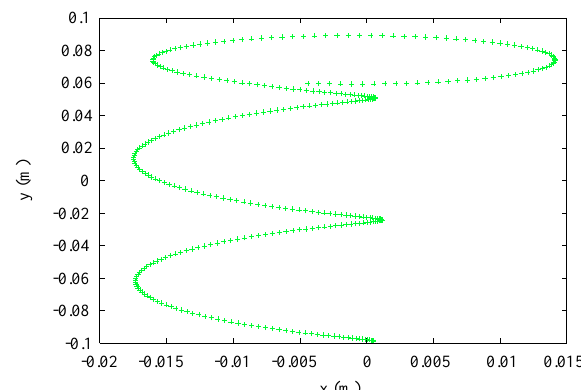
FIG. 6. (Color) Vertical drift with cusp motion from Fig. 5 in two dimensions.